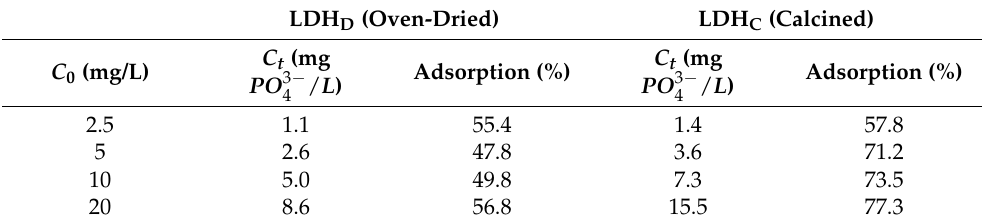
Table 1. Adsorption results for hydrotalcite when testing phosphate solutions from 2.5 to 20 mg/L. C 0 and C t refer to initial and final concentration, respectively. Variation coefficients (%) of triplicates were under 10% in all